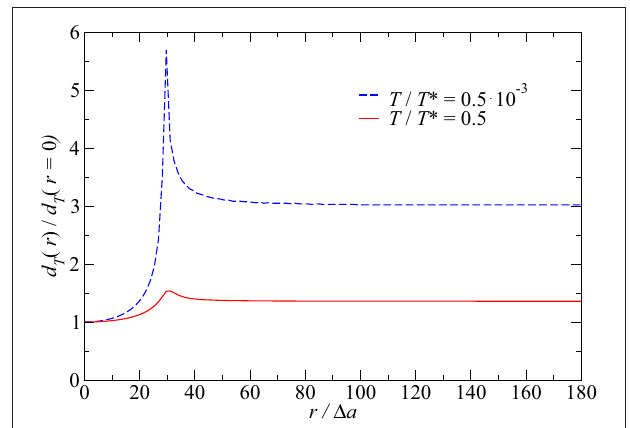
FIGURE 7 | Spatially resolved thermal displacement d T ( r ) normalized to the its value at r 0 at two different reduced temperatures T / T ∗ for the default = model. Lower and upper temperature are indicated by dashed blue and solid red lines,